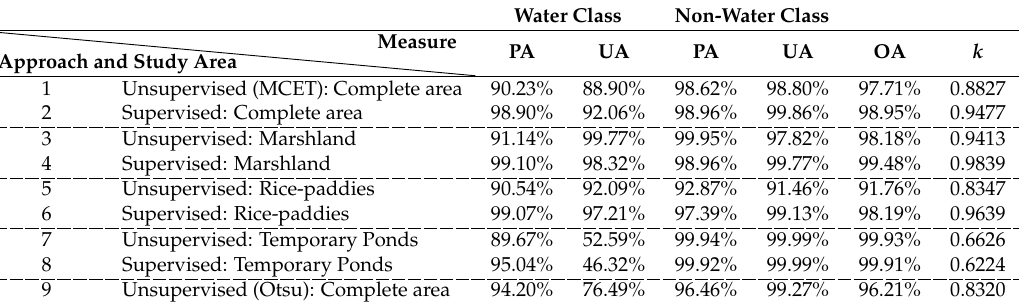
Table 8. Combined accuracy assessment for all 7 dates per approach and examined study